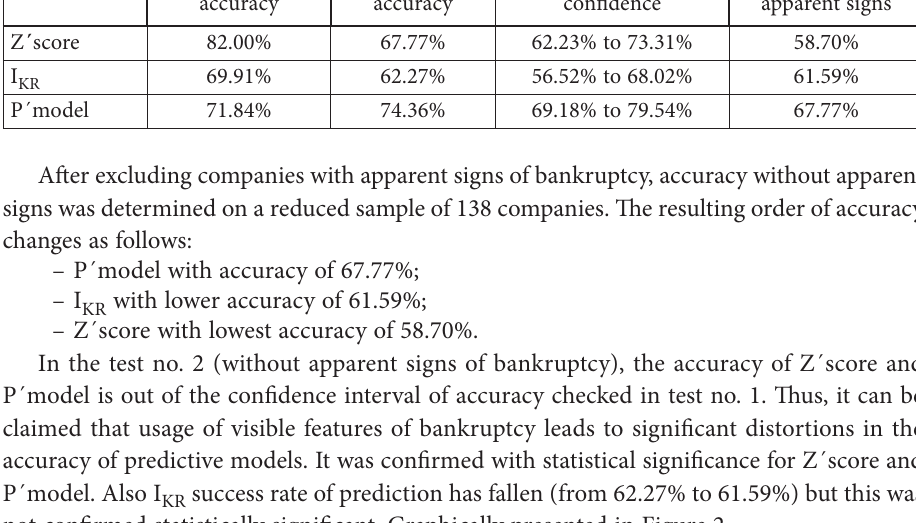
Table 6. Accuracy with and without taking into account apparent signs (source: authors) Original Model